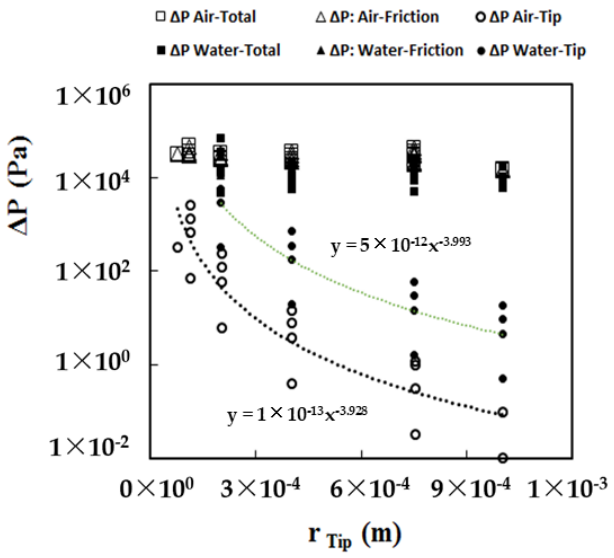
Figure 6. The pressure drop for friction, piston, and tip, for air and water with various tip sizes.